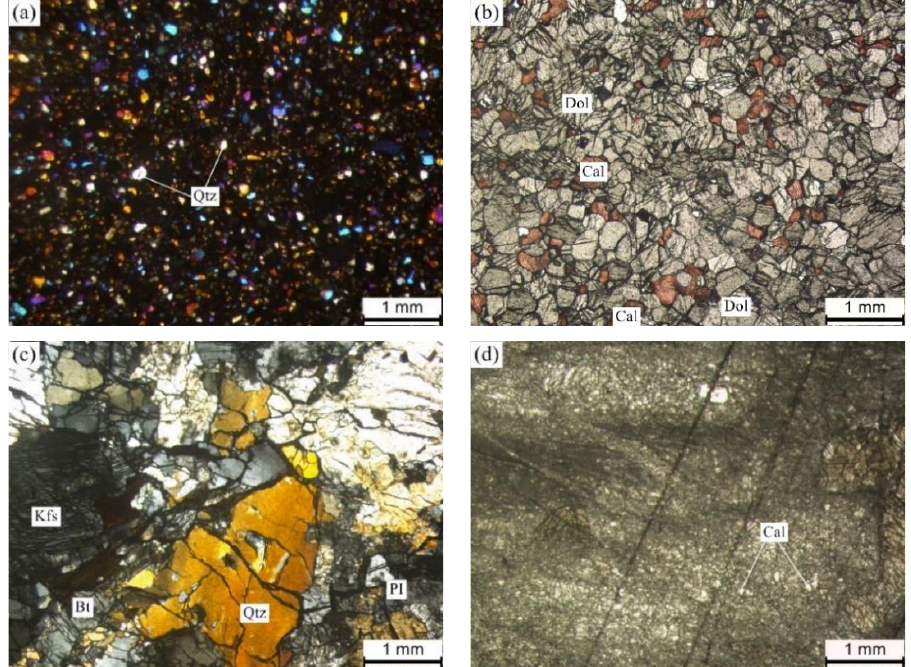
Figure 3. The microstructure map of the rock is obtained by the transparent thin slice experiment [50]. ( a – d ) are red sandstone, marble, granite and limestone, respectively (Qtz—quartz, Dol—dolomite, Cal—Calcite, Kfs—Potash feldspar, Bt—Biotite, Pl—Plagioclase).